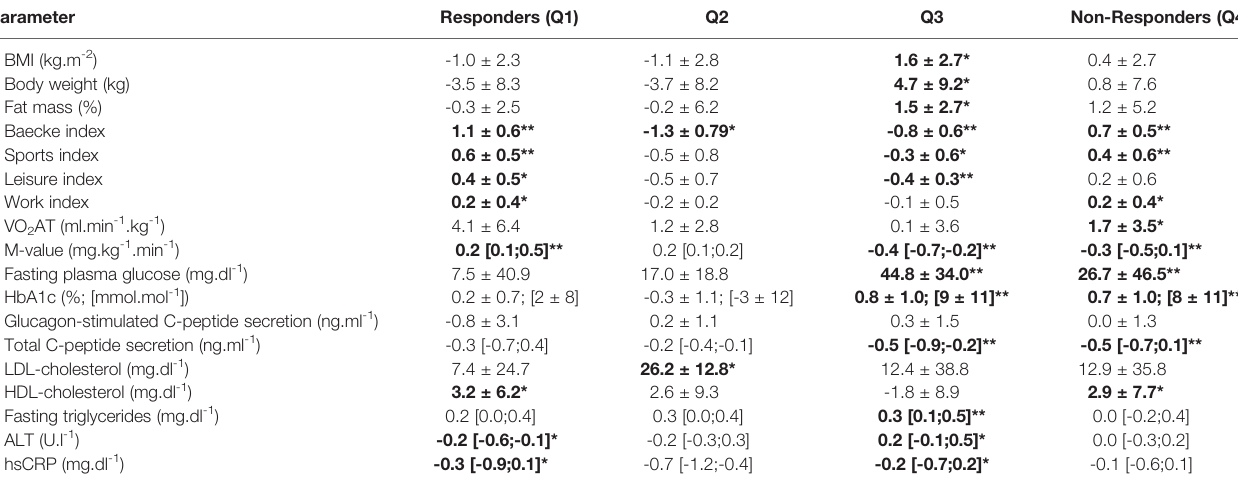
TABLE 2 | Subgroup analysis of changes ( D ) of anthropometric, performance and metabolic parameters based on response to changes in whole-body insulin sensitivity and PA participation over 5 years for patients with type 2 diabetes, divided into responders (n=17), Q2 (n=5), Q3 (n=23) and non-responders (n=30).